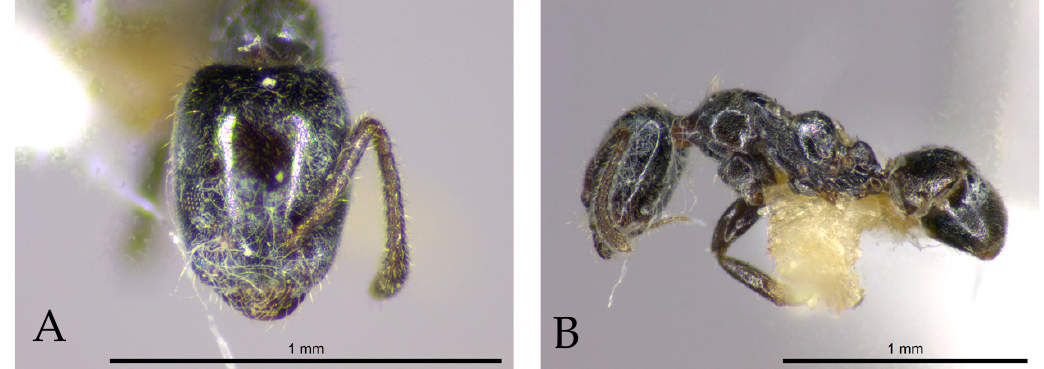
Figure 10. Head and lateral views of Anonychomyrma sp. O ( A , B ).